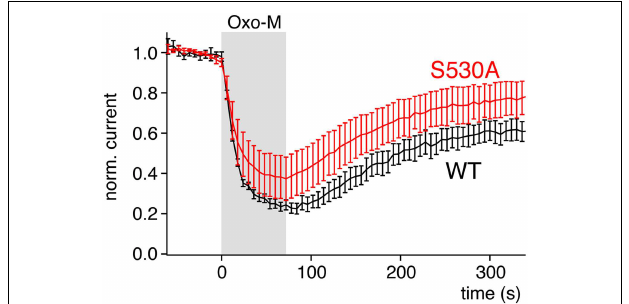
FIGURE 7 | Mutation of a PKC site of Kv7.2, S530A, does not abolish sensitivity to activation of PLC. Currents from Kv7.2 (WT) or the PKC site mutant channel Kv7.2(S530A) were recorded from CHO cells co-transfected with M1R. Activation of M1R by 10 µ M oxotremorine-M at the time indicated. Currents were evoked by voltage steps from − 60 to 0mV for 500ms. Currents amplitudes shown were measured at the end of each voltage step and normalized to current amplitude before application of the